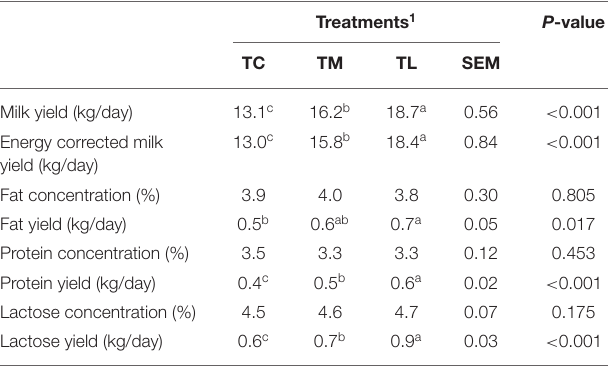
TABLE 6 | Effect of post-grazing sward height on milk yield and milk component yields and concentration by lactating cows. Treatments 1 P